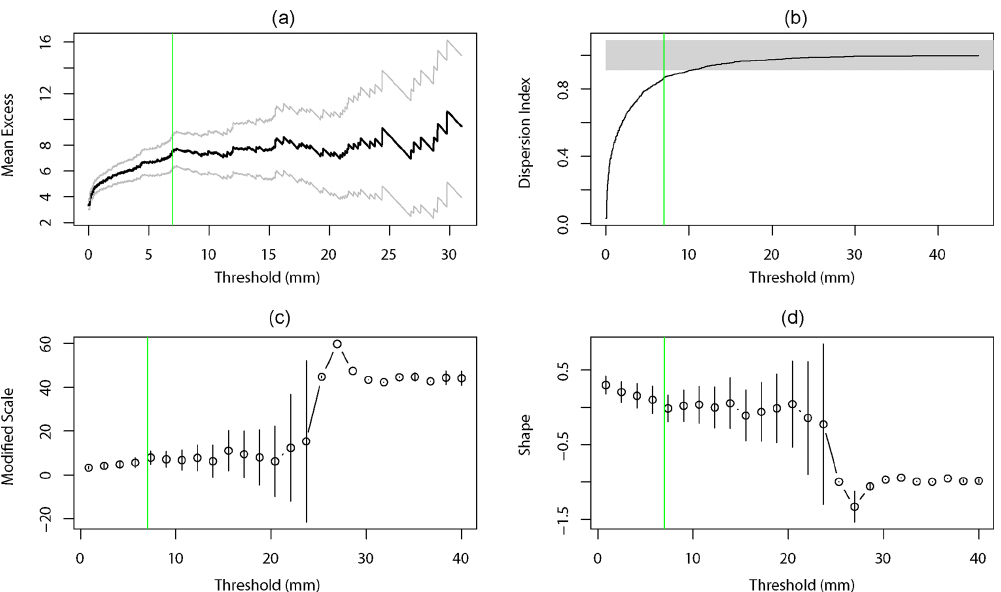
Figure A2. Graphical summary of RE threshold ( µ ) selection in Upper Mula: (a) mean residual life: mean value of observations over a threshold (mean excess). (b) Dispersion index. (c, d) Scale and shape parameter estimates from the GPD for a range of values of µ . Green line represents the µ (7mm) selected, implying a higher variability of its exceeding values in (a) , (c) , and (d) and posing a limit in (b) from which dispersion index estimates are near the theoretical value